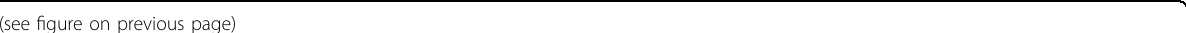
Fig. 1 Giant ANK2 knockout monkeys display reproducible brain volume loss, but do not show ASDs symptoms and have normal sleep – wake cycle. a Schematic diagram showing two sgRNAs which target the speci fi c exon of giant ANK2. b Example axial, sagittal, and coronal slices of structural images of each knockout (KO) monkey at 24-month. L-left; R-right. c – e Frequencies and durations of both active and passive social interaction ( c ), exploratory and stereotypical behaviors ( d ), staying alone and self-grooming ( e ) between KO and WT monkeys. f , g No signi fi cant difference of the sleep state ( f ) (including the duration of total sleep and relaxed sleep, and the percentage of relaxed sleep in total sleep) and the activity ( g ) (including day-time activity, night-time activity and ratio of day-time/night-time activity) between KO and WT monkeys. All data in ( c – g ) were presented as means ±